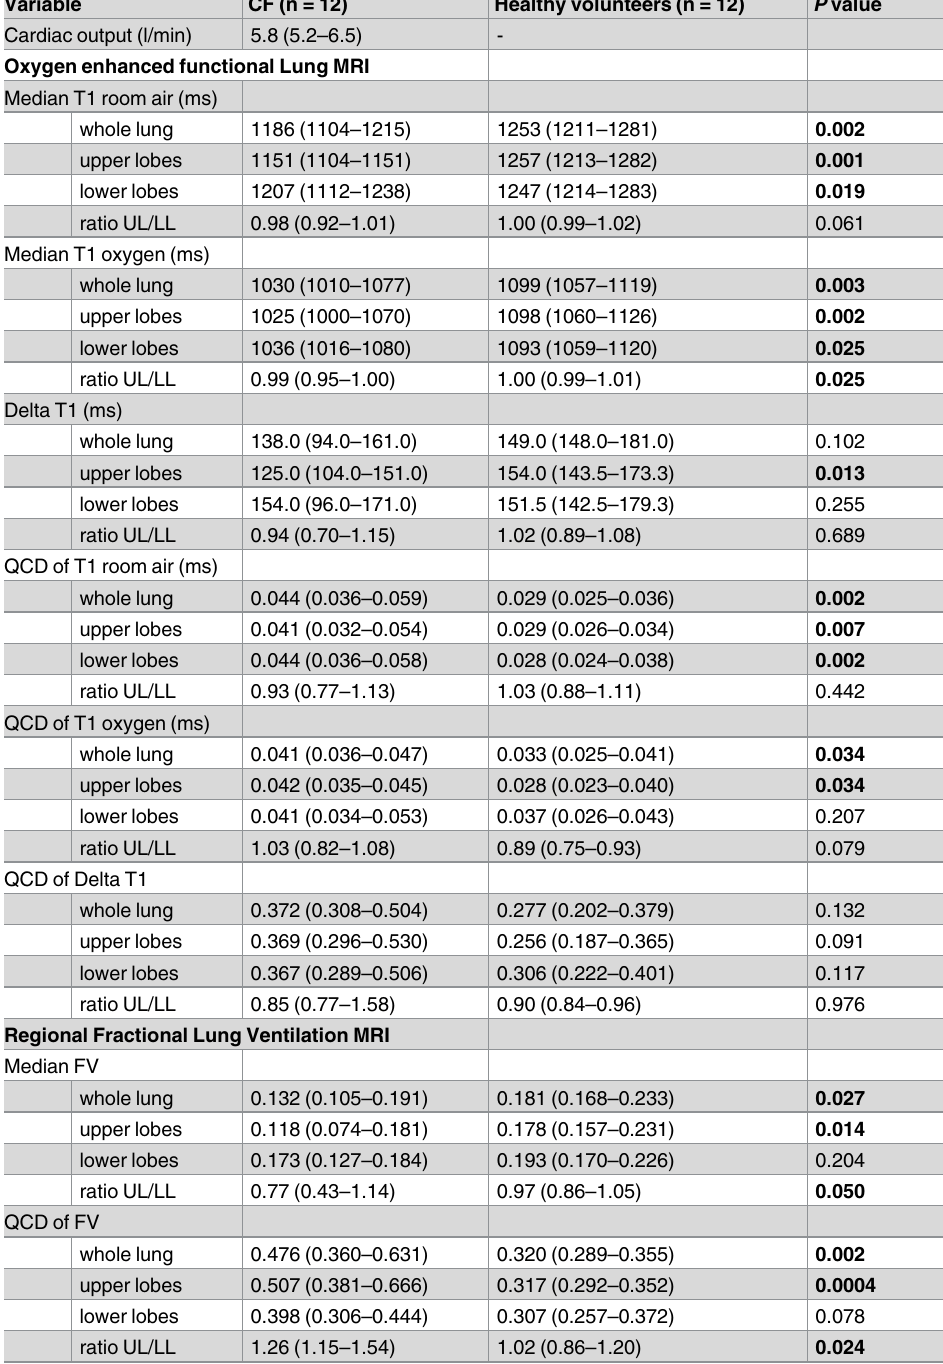
Table 2. Comparison of CF patients to healthy